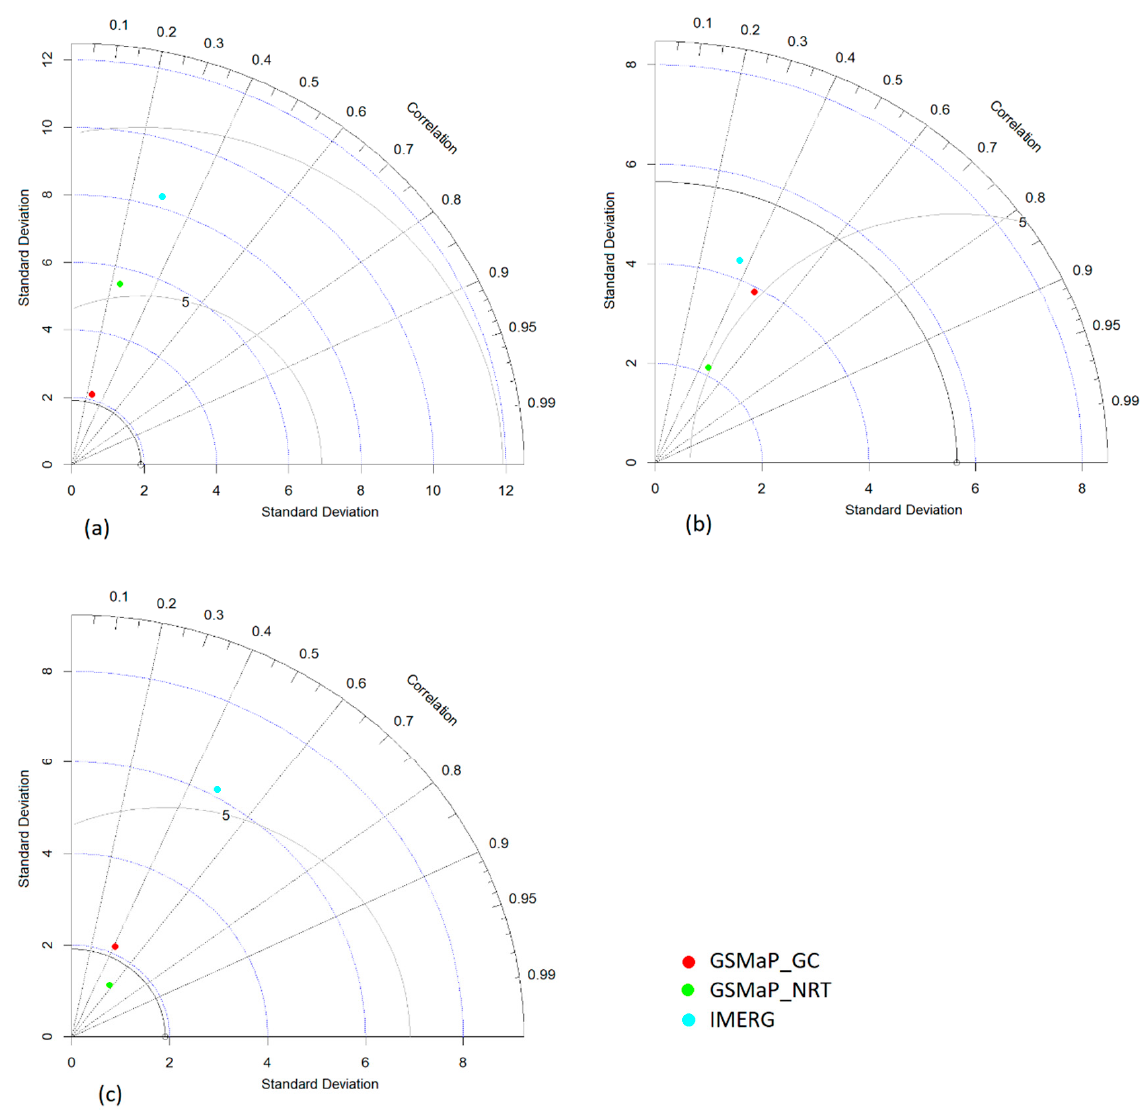
Figure 5. Taylor diagram of in situ and satellite daily rainfall during 2000–2015 at ( a ) Baghdad, ( b ) Musol, ( c ) Basrah.